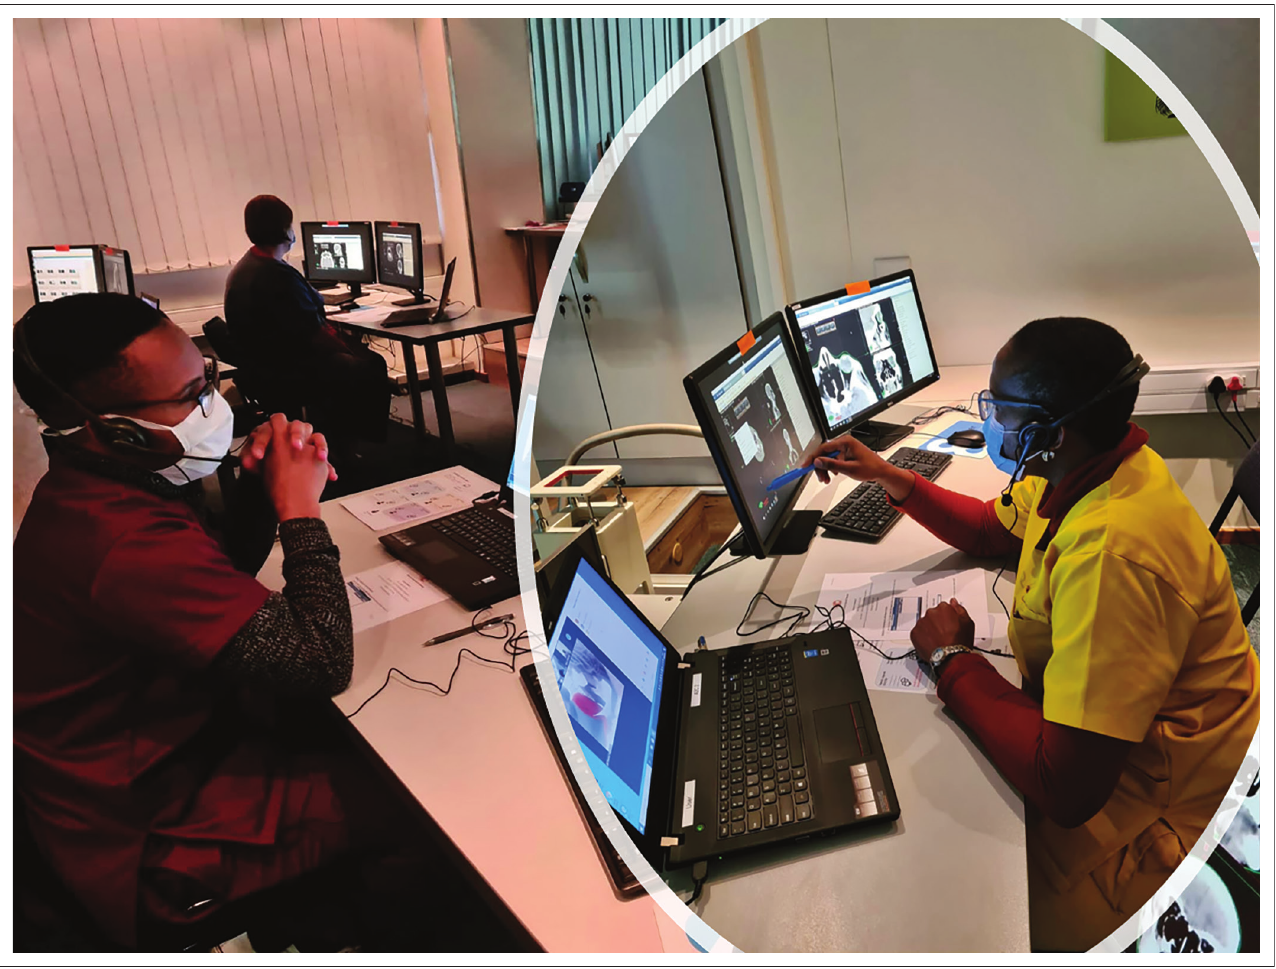
FIGURE 1: Classroom assistants monitoring remote teams during contouring